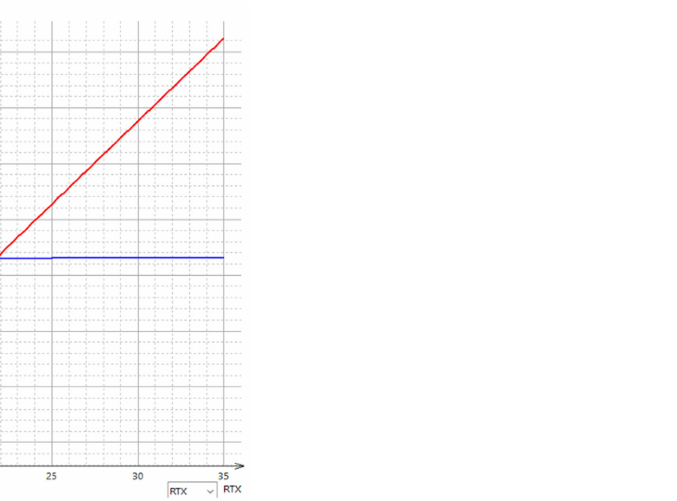
Figure 16. R TX variation simulation results of circular coil model: L 1 in the function of R TX , L 2 in the function of R TX .